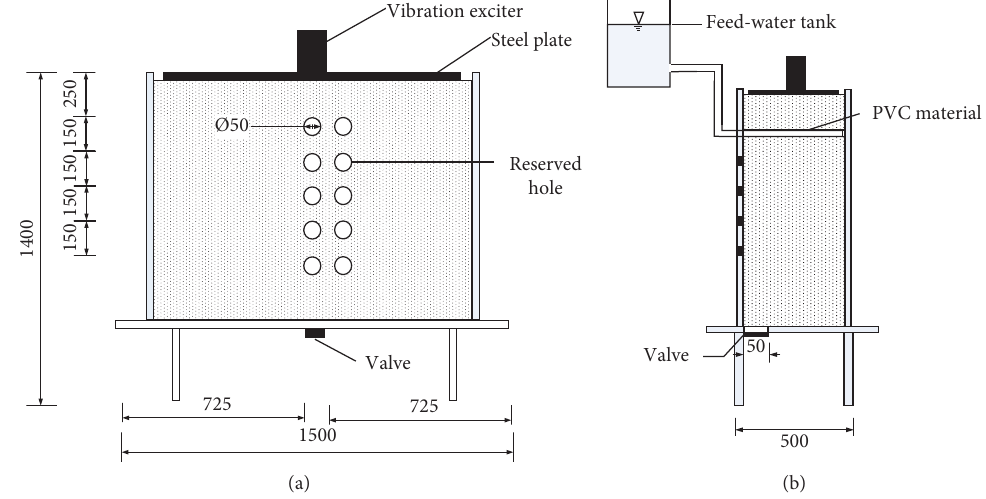
Figure 2: Schematic diagram of the model box. (a) Front view of the model box. (b) Side view of the model box.